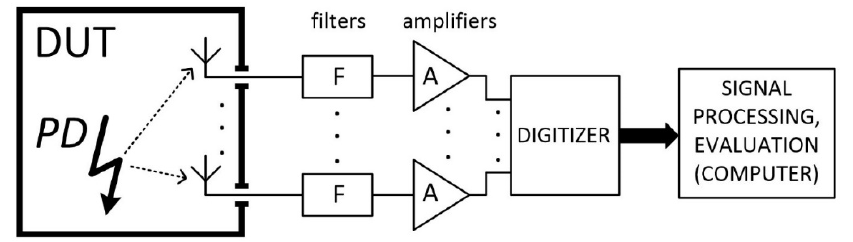
Figure 2. The basic setup for UHF detection of partial discharges.